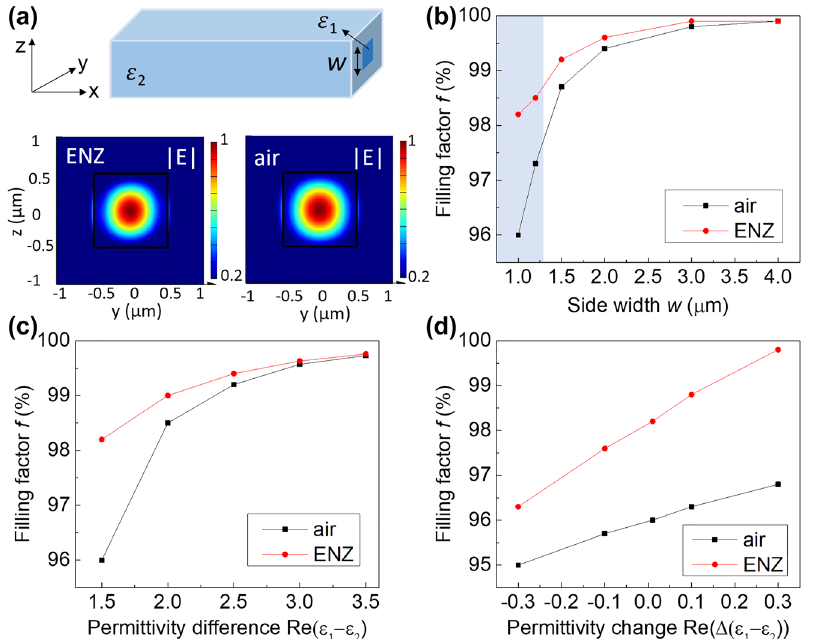
Figure 1: Mode confinement and the filling factor in an ENZ-based optical waveguide. (a) Scheme of a three-dimensional square waveguide with a dielectric core and the associated mode profile under transverse electric (TE) polarization. The electric field is more confined at the = 2.25, 𝜀 = 0.001 + 0.01 i ) compared to the air environment ( 𝜀 = 2.25, 𝜀 = 1). Along core regime surrounded by the ENZ environment ( 𝜀 1 2 1 2 the x axis, a smaller mode leakage via evanescent waves appears for the ENZ-based waveguide. Waveguide side width is w = 1 μ m. (b) The mode-filling factor f of the ENZ-based waveguide is higher than the dielectric waveguide, especially for waveguide side lengths at the = 3.24 and 𝜀 = 1 for the air waveguide, and 𝜀 = 2.25 and subwavelength scales ( w < 𝜆 = 1.3 μ m, shaded region). The permittivity is 𝜀 1 2 1 𝜀 = 0.001 + 0.01 i for the ENZ-based waveguide. (c) The mode filling factor f of the ENZ-based waveguide is higher than the dielectric 2 − 𝜀 ) < 2) between the cladding and the core region. Here 𝜀 varies and waveguide, especially when the permittivity contrast is small (Re( 𝜀 1 2 1 𝜀 = 0.001 + 0.01 i and 𝜀 = 1, respectively). (d) The mode filling factor f is highly tolerant to variation in the real is fixed for both systems ( 𝜀 2 2 2 = − 0.3 + 0.01 i to 0.3 + 0.01 i ), and vice versa is fixed and 𝜀 varies for the ENZ system ( 𝜀 part of permittivity in the cladding layer. Here 𝜀 1 2 2 = 2.9 to 3.5). The plotting wavelength is 𝜆 = 1.3 μ m for all. The side width of a square-shaped core is w = 1 μ for the air case ( 𝜀 1